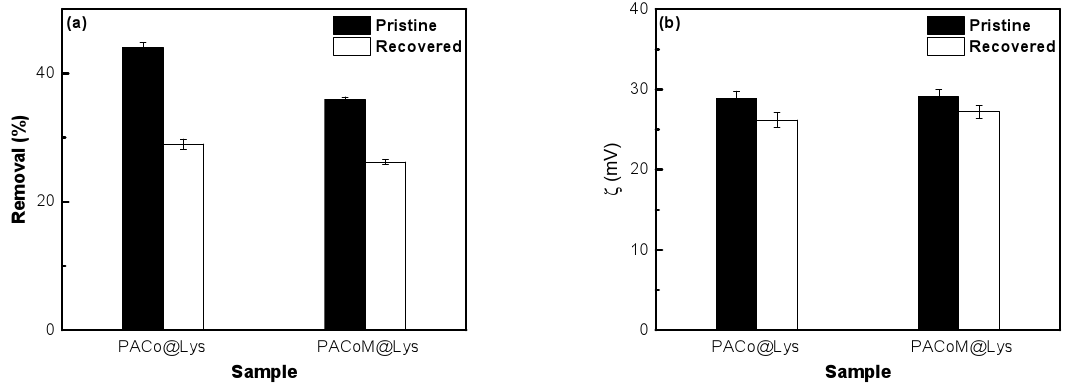
Figure 11. Comparative removal efficiency ( a ) and zeta potential at pH = 4 ( b ) of pristine and regenerated samples.